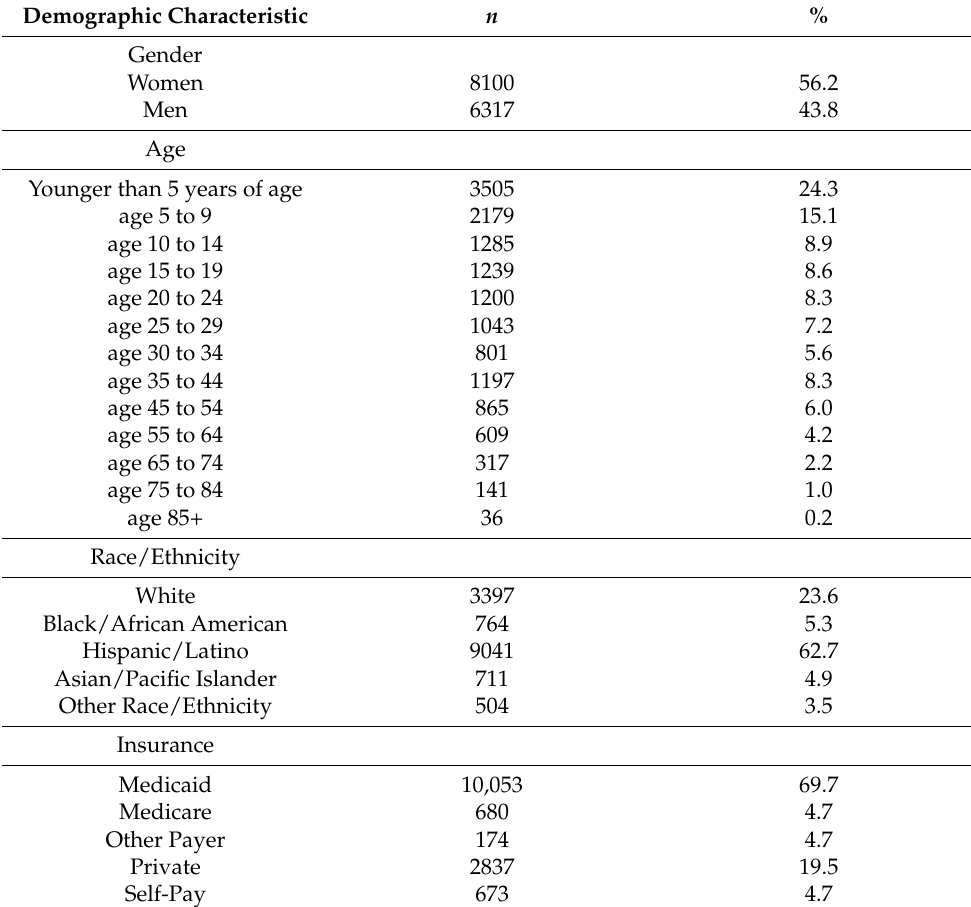
Table 2. Frequency and percentage by demographic characteristics of the population with an acute urticaria-related emergency department visit, San Joaquin Valley,